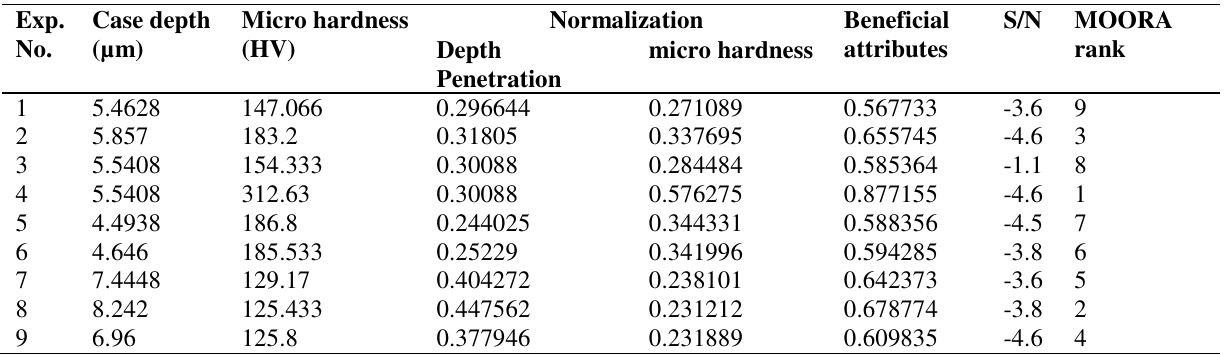
Table 4, Results of (MOORA)